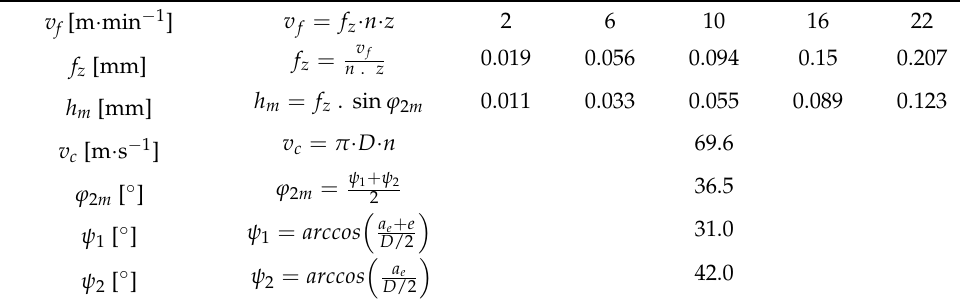
Table 2. Kinematic parameters and machine